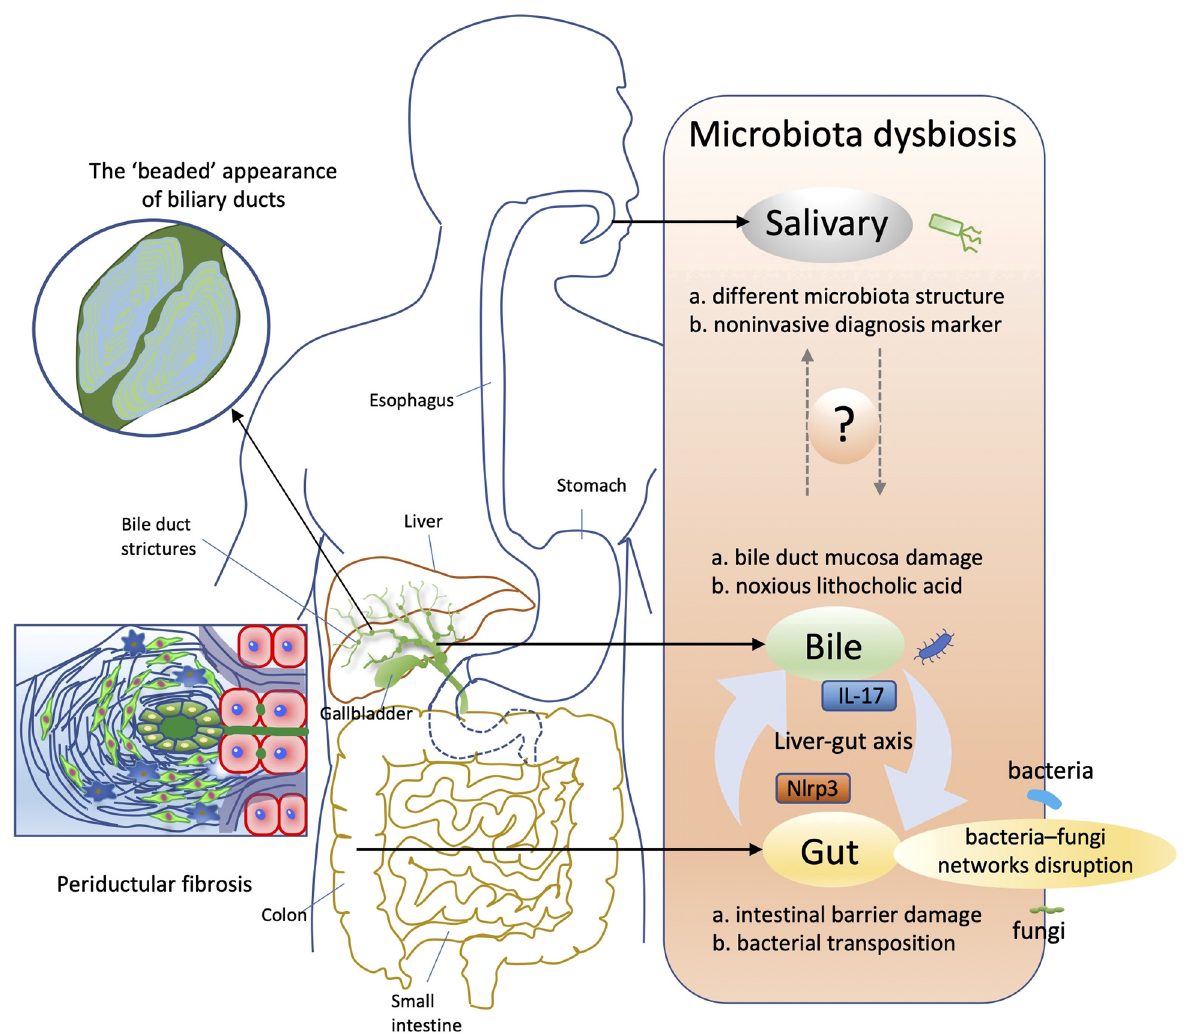
Figure 1: PSC and microbiota dysbiosis. PSC shows a characteristic “ beaded ” appearance of biliary ducts as a pattern of alternating strictures and dilatations. It pathologically characterises as periductular fi brosis. Dysbiosis of microbiota in the gut, bile, and saliva contribute to the pathogenesis of PSC. The liver – gut axis bridges the path for microbiota in bile and gut. On one hand, bacterial species disrupt the intestinal epithelial barrier and bacterial products activate the Nlrp3 in fl ammasome via the liver – gut axis, inducing Th17 priming in the liver. On the other hand, the bile microbiome contributes to PSC by increasing damage to the